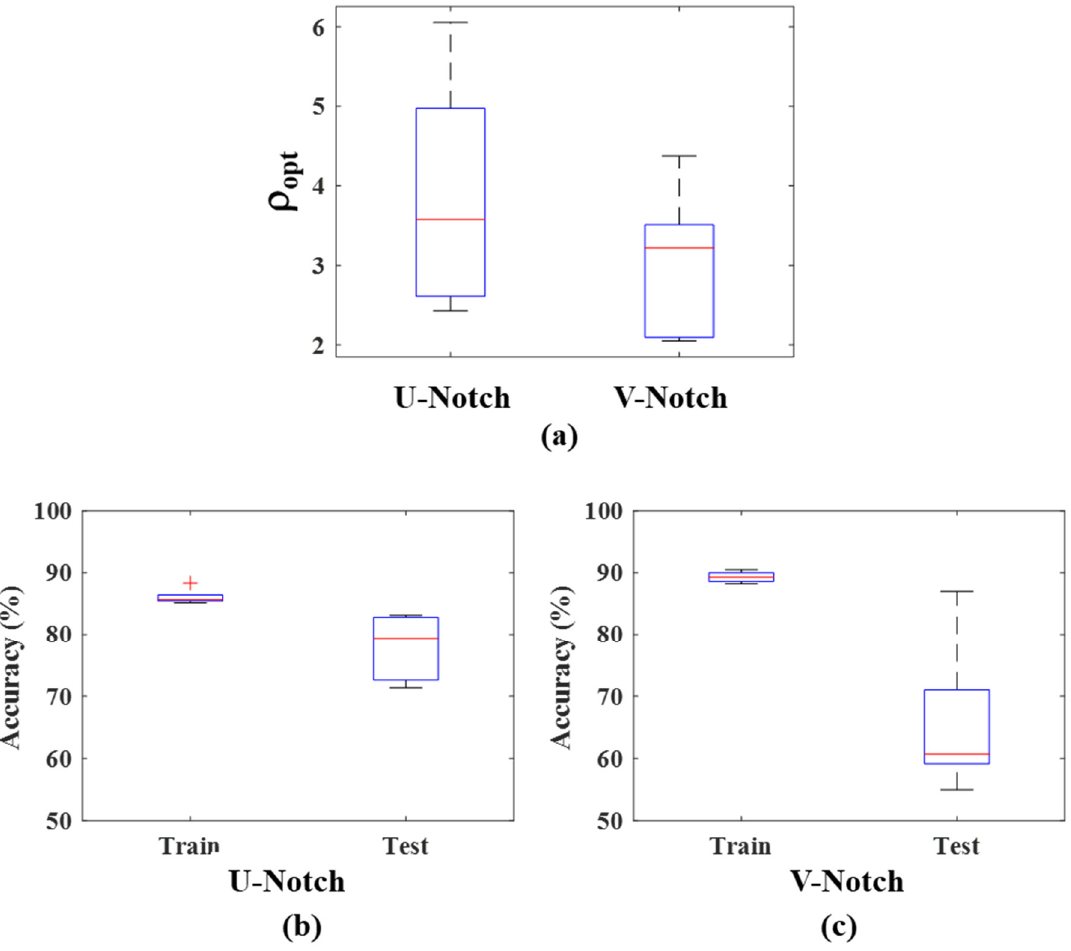
Figure 17. ( a ) Optimal threshold distribution for both sets of specimens for the CP regime. Average training and testing accuracy across all hold-out-based validation iterations for ( b ) U-notched and ( c ) V-notched specimens in the CP regime. The red lines denote the medians of the distributions.